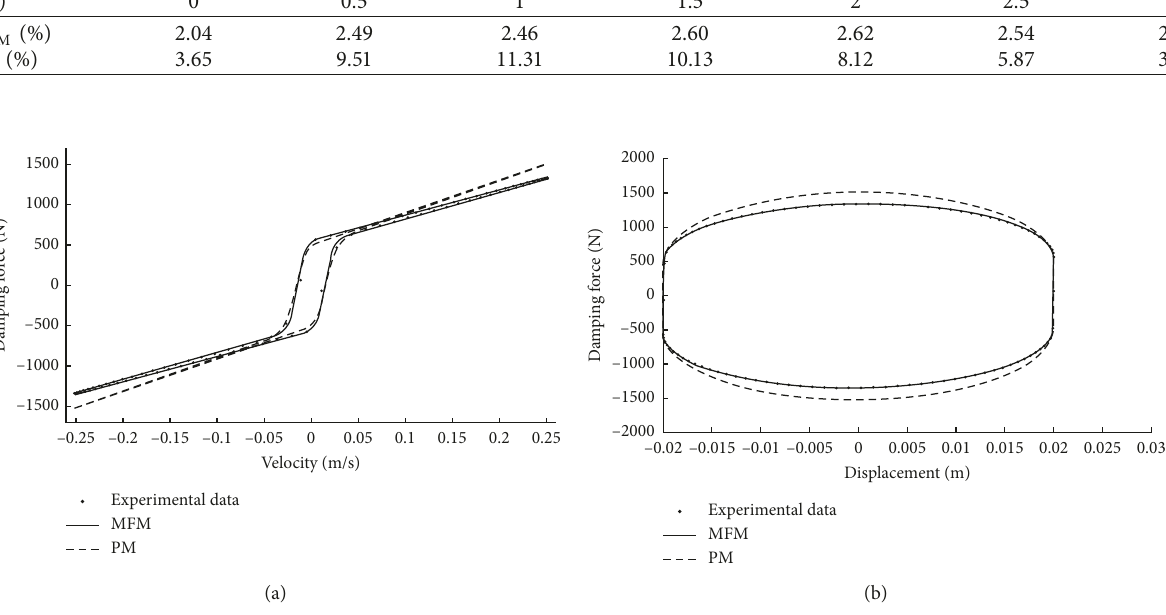
0.02m, f 2Hz, and I 1A (a) Piston speed-damping (cid:31) (cid:31) (cid:31)